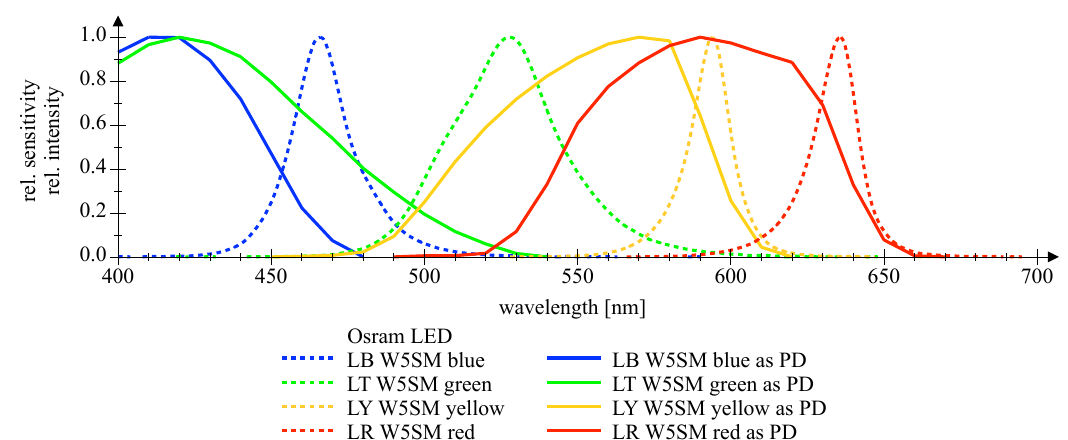
Figure 9. Normalized spectral measurements of Osram Golden Dragon series LED, deployed as emitter (dashed lines) and as detector (solid lines), respectively.